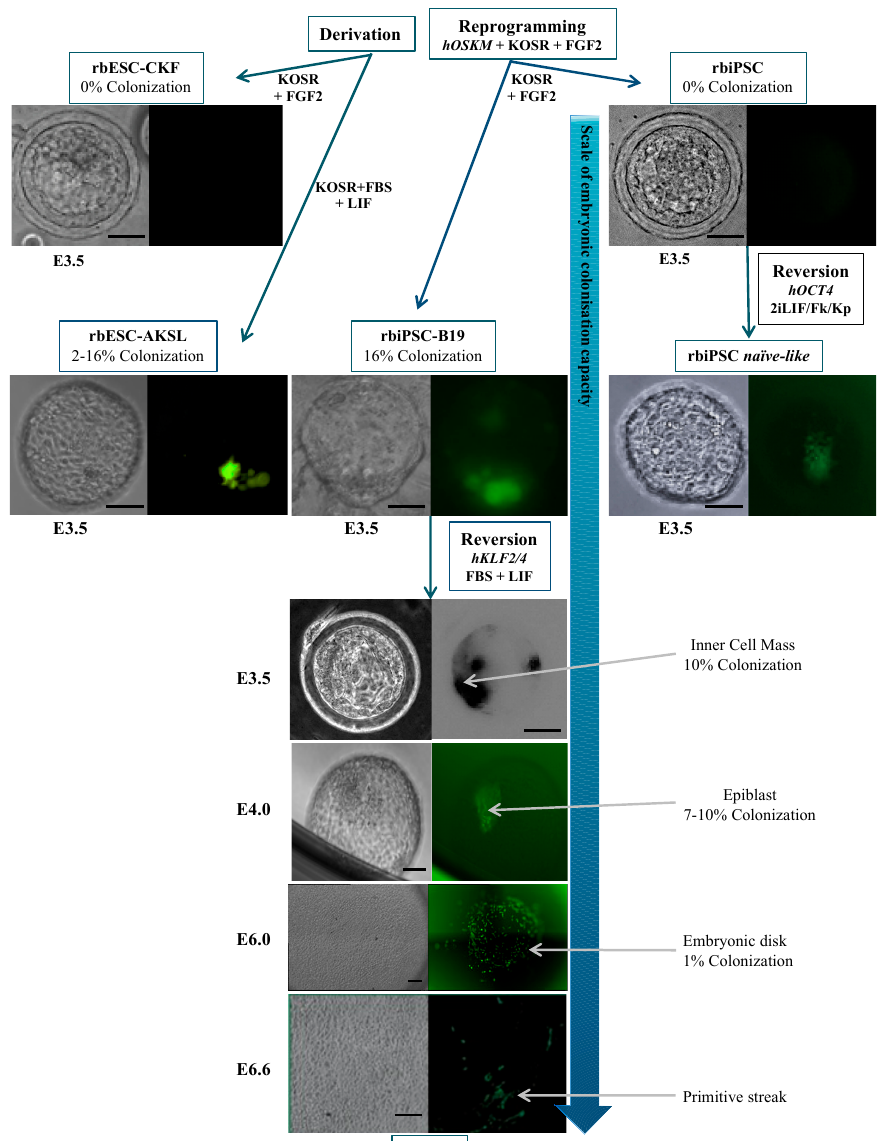
Figure 2. Embryonic colonization capacity of several rabbit pluripotent stem cell lines produced by our research group [47,51,65] or the Japanese team of Atsuo Ogura [61,72]. rbESC: rabbit embryonic stem cell; rbiPSC: rabbit induced pluripotent stem cell; KOSR: knockout serum replacement; FGF2: fibroblast growth factor 2; FBS: fetal bovine serum; LIF: leukemia inhibitory factor; 2i: MEK and GSK3 β inhibitors; Kp: kenpaullone; Fk: forskolin; hOSKM: human OCT4, SOX2, KLF4, and c-MYC factors; CKF: clumps/KOSR/FGF2; AKSL: accutase/KOSR + FBS/LIF; rbEKA: rabbit enhanced KLF activity. Scale bar = 50 μ m.